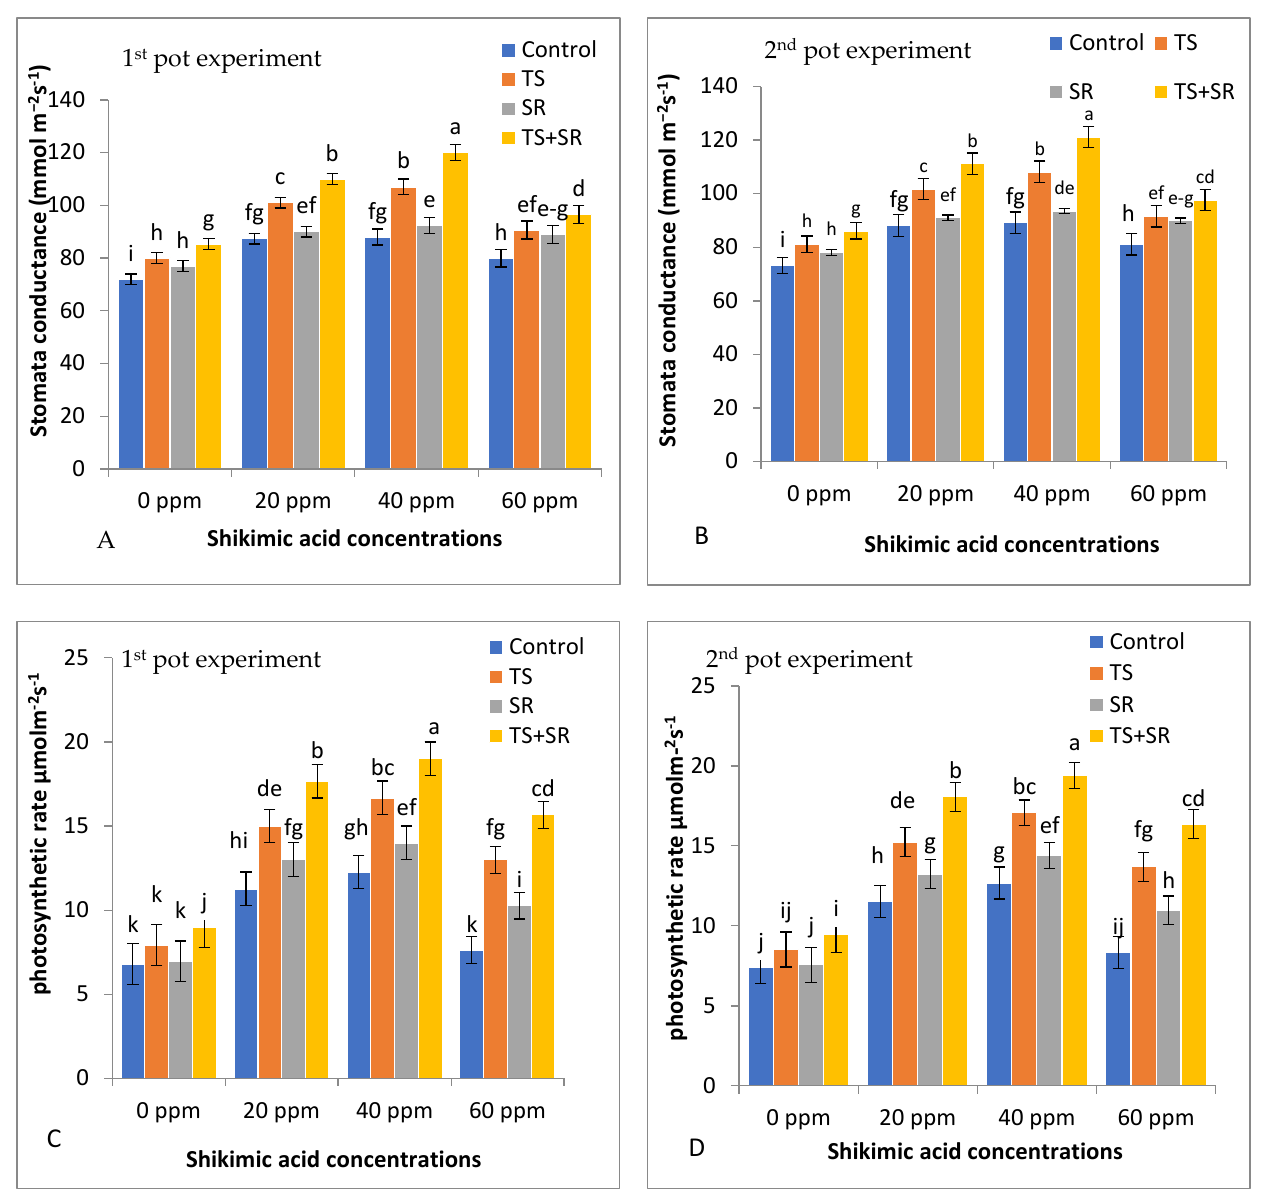
Figure 2. Effect of the interaction between seed priming of shikimic acid concentration (0, 20, 40, 60 ppm) and foliar applications with water (control), T. asperellum (TS), S. rochei (SR), T. asperellum + S. rochei + (TS + SR), and on ( A ) Stomata conductance in 1st pot experiment ( B ) Stomata conductance in 2nd pot experiment, and ( C ) photosynthetic rate in 1st pot experiment, ( D ) photosynthetic rate in 2nd pot experiment of squash plants. Standard errors of the mean are shown as vertical bars; the LSD test indicates that differences between values in each bar that are marked by different letters are significant at p ≤